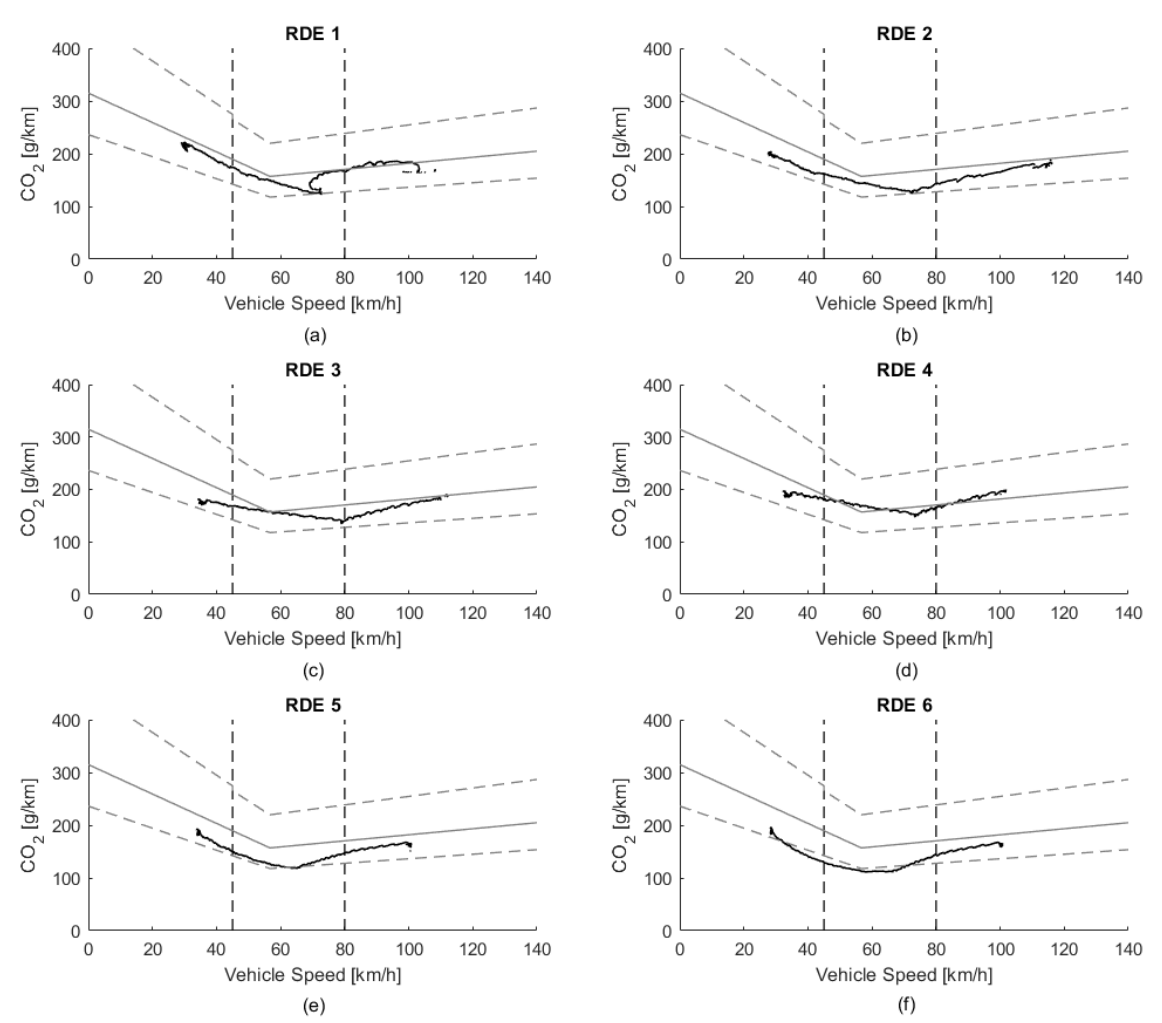
Figure 4. CO 2 curve, tolerances, and MAWs obtained for cycles RDE 1 ( a ), RDE 2 ( b ), RDE 3 ( c ), RDE 4 ( d ), RDE 5 ( e ), RDE 6 ( f